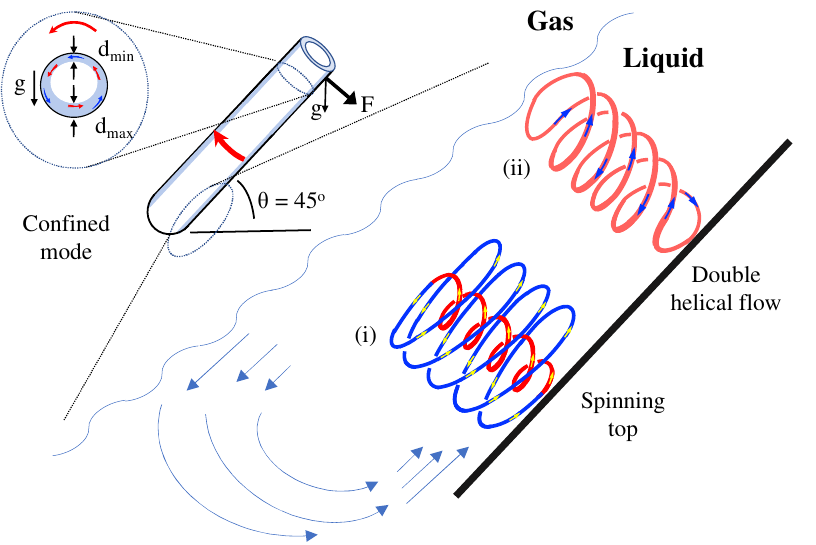
Figure 2. Salient features of the vortex fluidic device (VFD) and the associated high shear (i) spinning top and (ii) double helical topological fluid